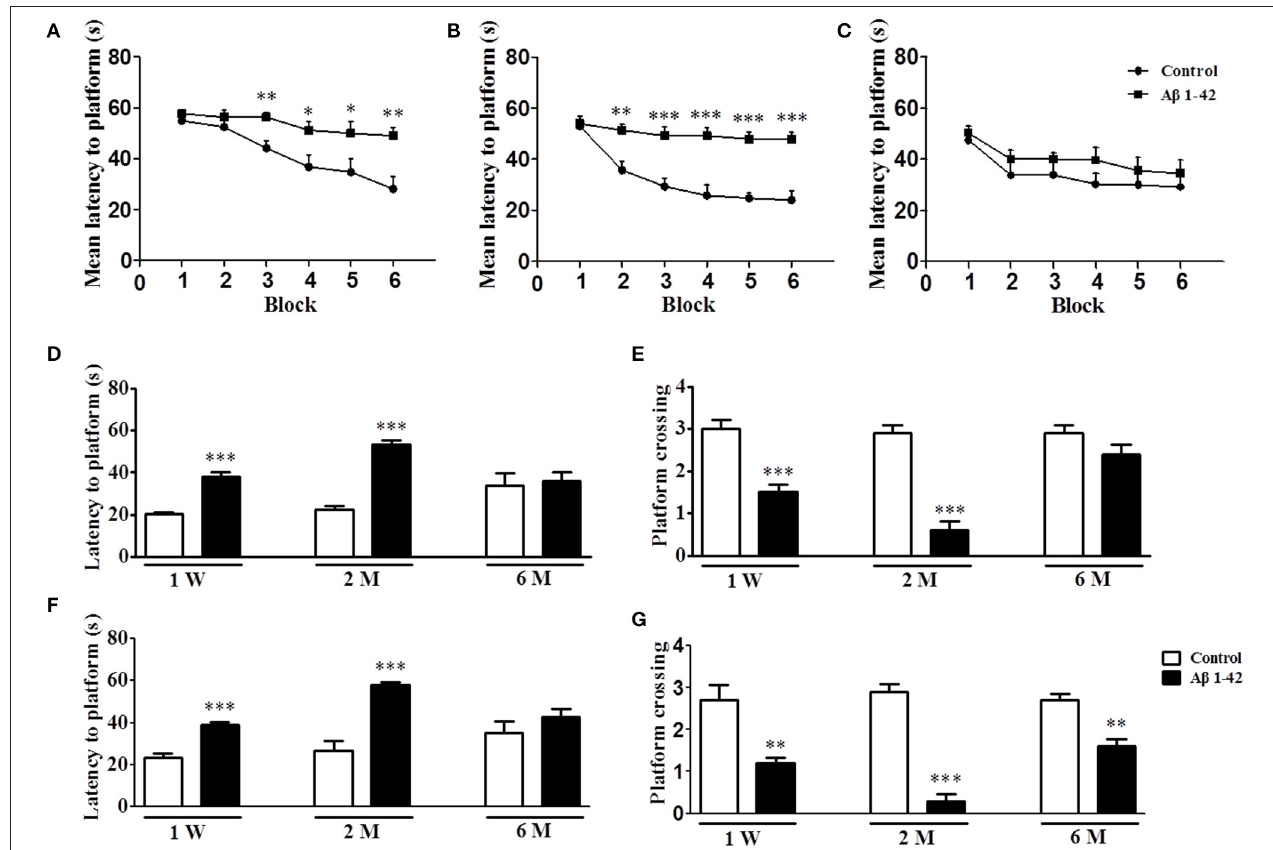
FIGURE 1 | A β 1-42 induced spatial memory impairment in the Morris water maze task at 1 week, 2 and 6 months after intracerebroventricular microinjection of A β 1-42. During the acquisition trials of the water maze task, learning curve were tested after intracerebroventricular microinjection of A β 1-42 1 week (A) , 2